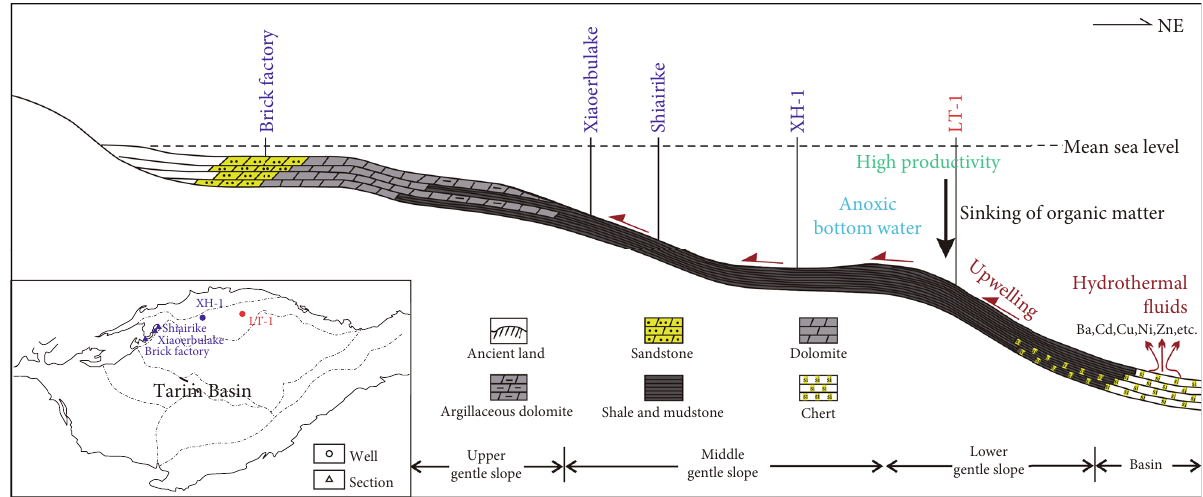
Figure 10: Schematic model of organic matter accumulation of the Lower Cambrian Yuertusi Formation in the Tarim Basin (modi fi ed from [19]).